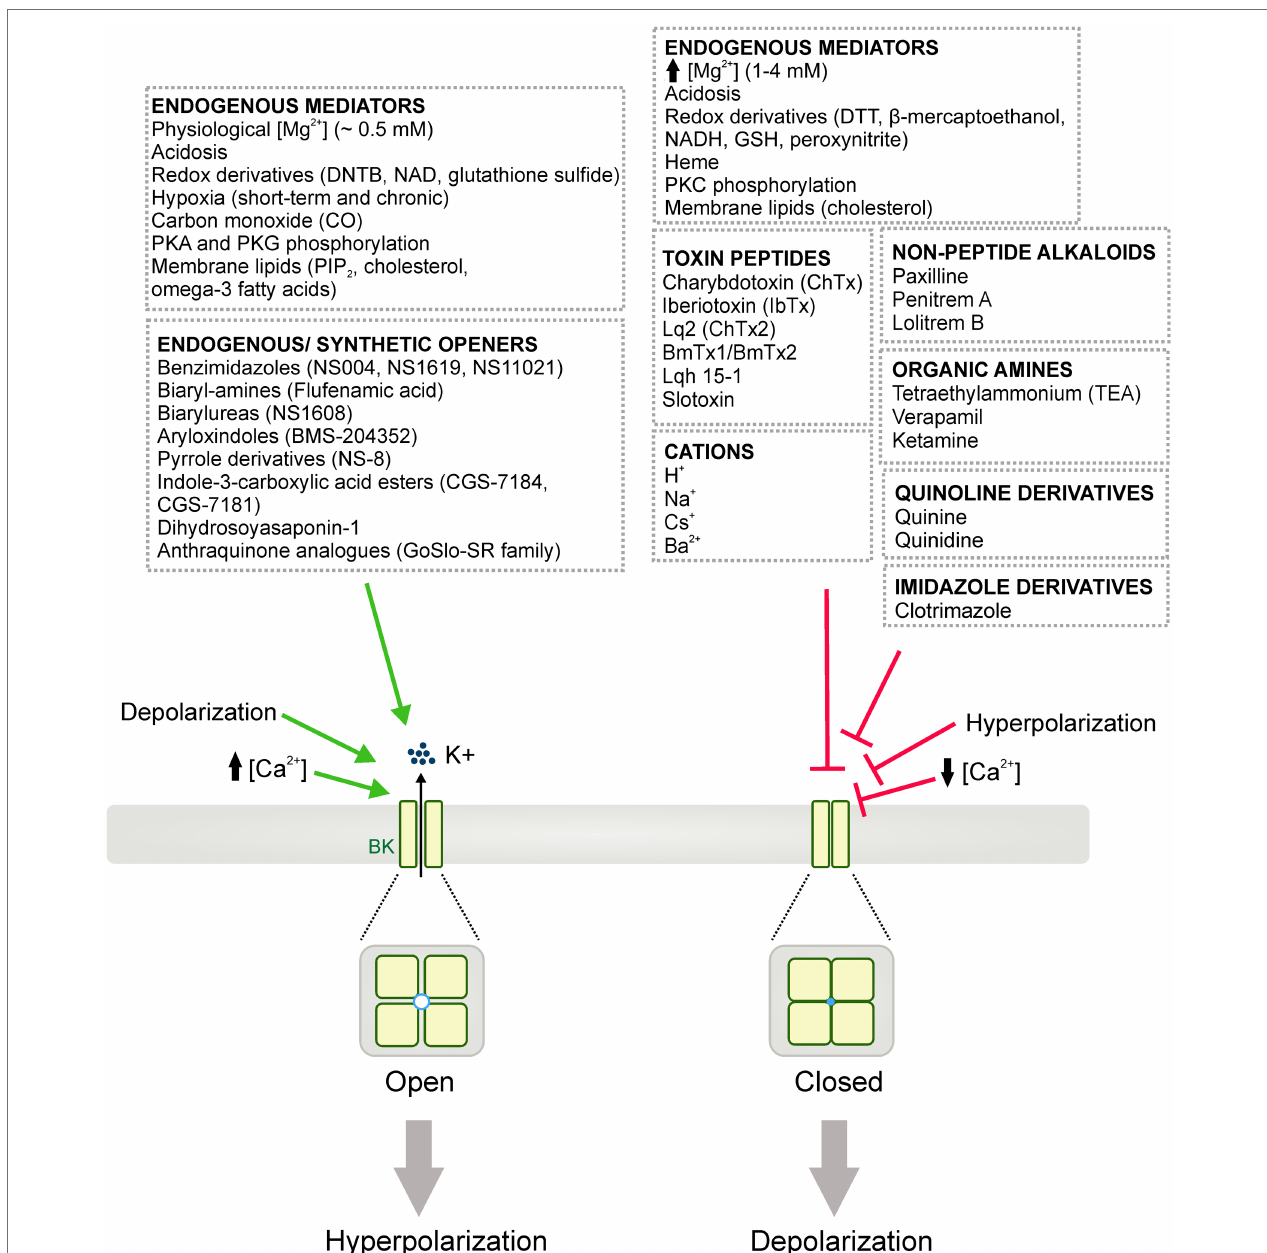
FIGURE 3 | Diagrammatic summary of the pharmacology of BK channels. BK channels can be activated (i.e., opened) or blocked (i.e., closed or inhibited) leading to cell membrane hyperpolarization and depolarization, respectively. Diverse endogenous mediators, redox derivatives and, signaling proteins are able to either potentiate or inhibit BK channel activity. Numerous BK channel inhibitors/blockers have been also reported, including: toxin peptides from scorpion venoms, non- peptide alkaloids, organic amines, quinolone and imidazole derivatives. Additionally, an extensive list of cations including H + , Na 2+ , Cs + and Ba 2+ are shown to influence BK channel activity. Similarly, endogenous and synthetic openers have been widely studied as experimental tools and potential therapeutic approaches for different vascular or neurological disorders involving BK